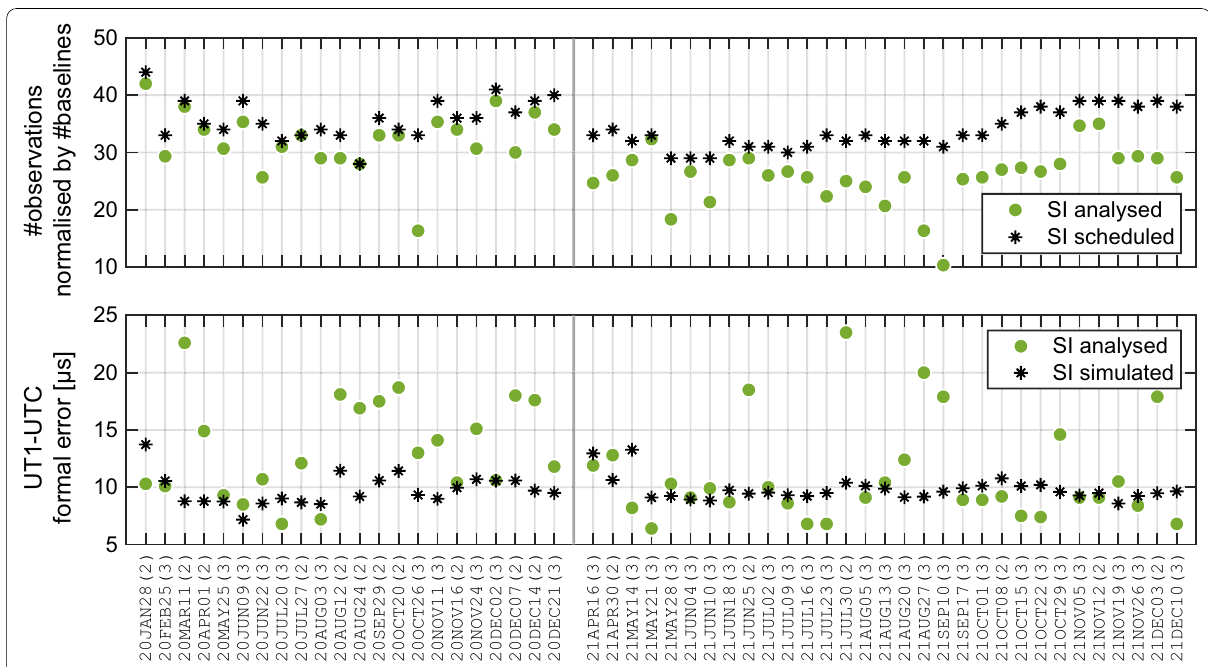
Fig. 4 Top: number of observations normalised by number of baselines of the SI sessions as scheduled (black stars) and as used in the analysis (green circles). Bottom: UT1 UTC (mean) formal error in µs of the SI sessions as simulated (black stars) and as used in the analysis (green circles). The − labels on the x-axis show the dates of the SI sessions and in braces the number of stations used in the